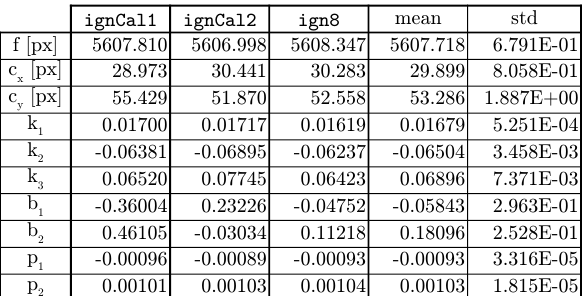
Table 3. Parameters of the Brown-Conrady distortion model with 10